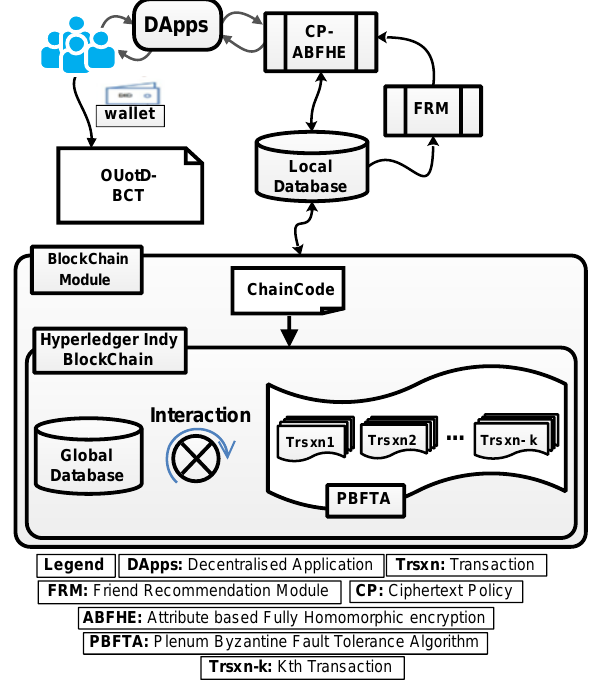
Fig. 1. The proposed sensitive data protection model